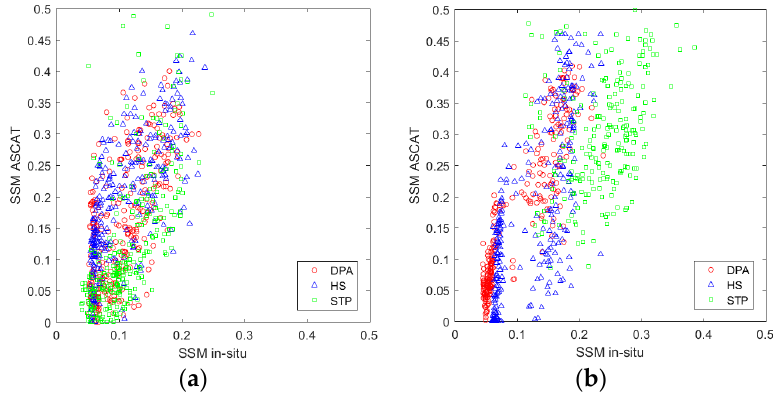
Figure 9. Scatter diagram of in situ and predicted SM from ASCAT for all different land cover types in ( a ) 2010 and ( b ) 2011. The AUSTRALIA sites include AU_DPA, AU_HS, and AU_STP.